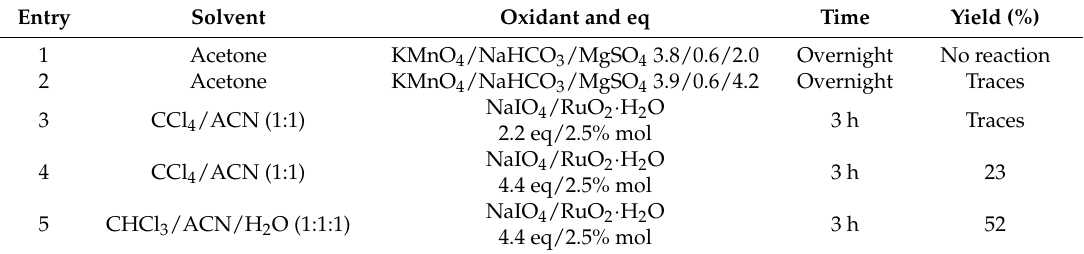
Table 1. The optimization of the conditions for the oxidation of compound 3 . All the reactions were performed at room temperature.